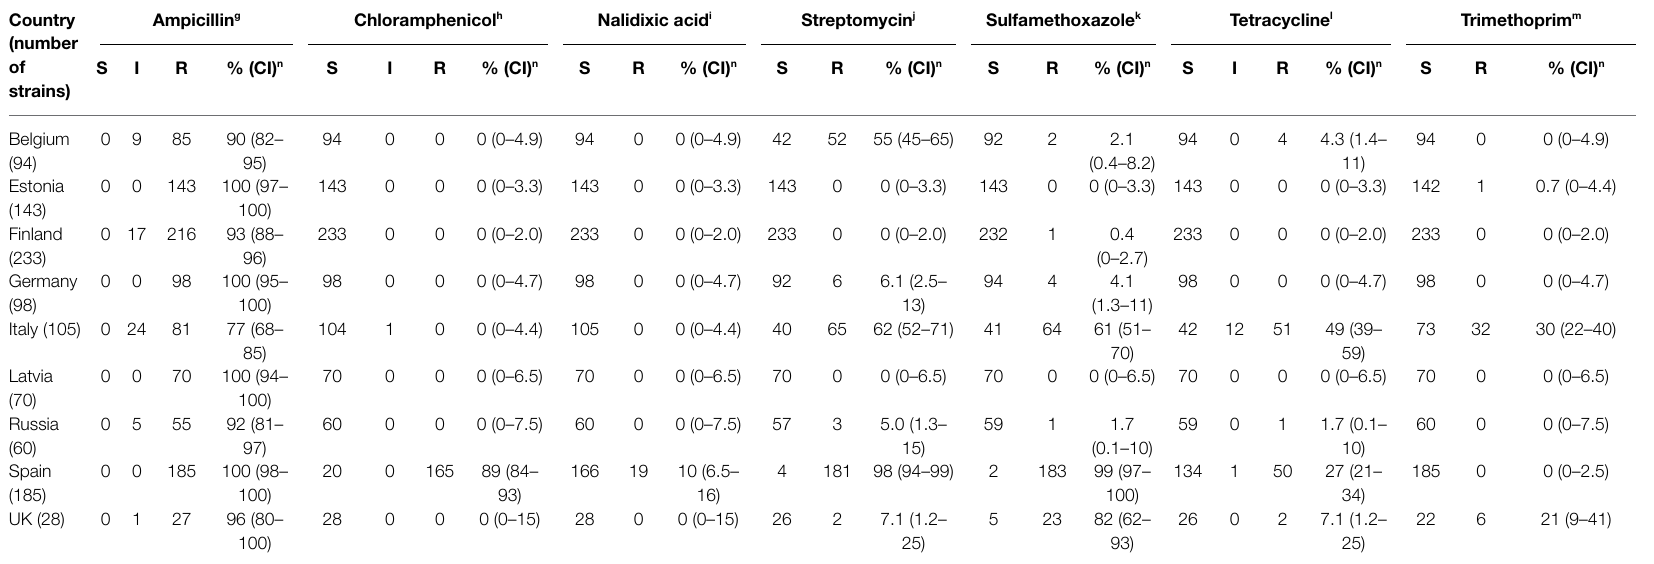
TABLE 1 | Number of porcine Yersinia enterocolitica 4/O:3 strains resistant to antimicrobials. All strains were susceptible to cefotaxime a , ceftiofur b , ciprofloxacin c , florfenicol d , gentamicin e , and kanamycin f . Country